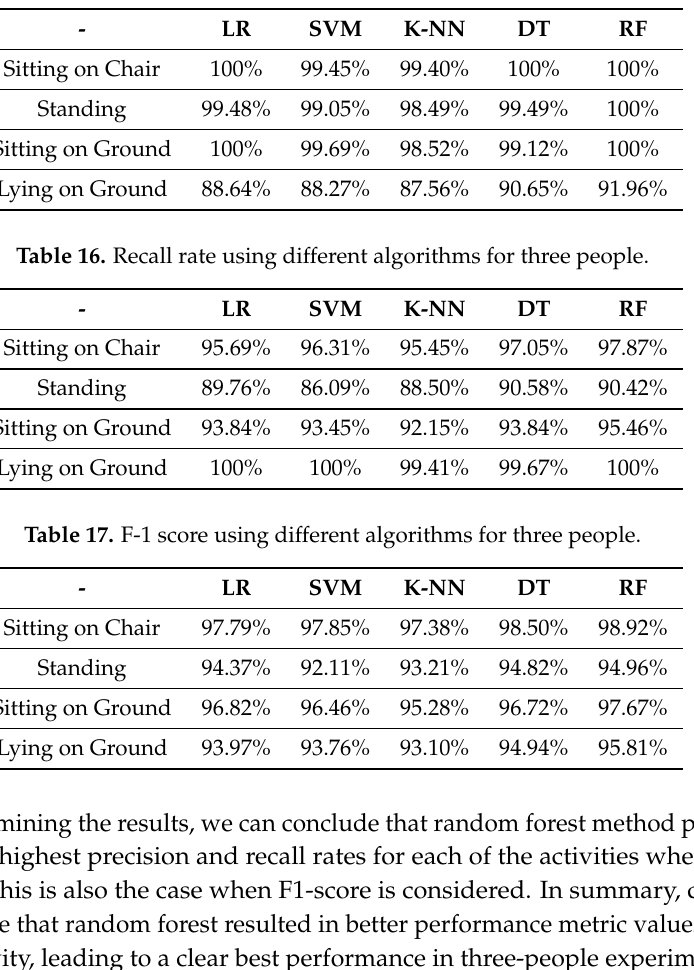
Table 15. Precision rate using different algorithms for three people.